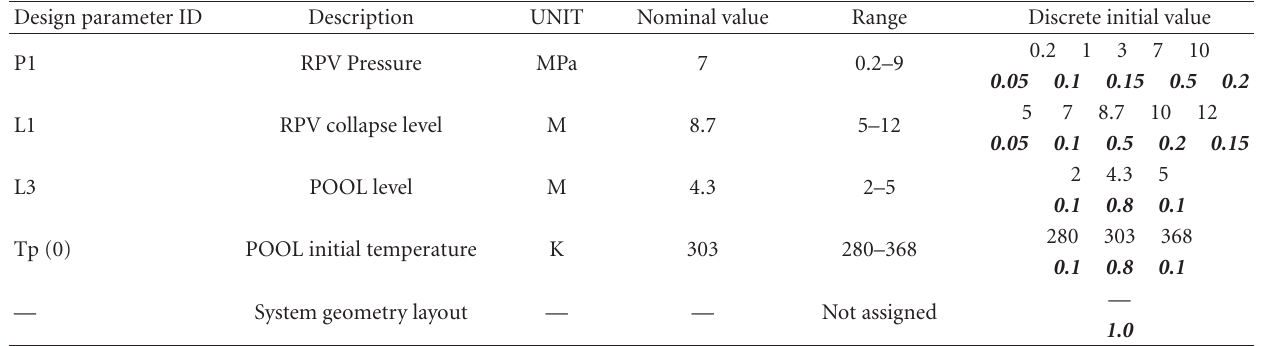
Table 3: Design parameters case b.